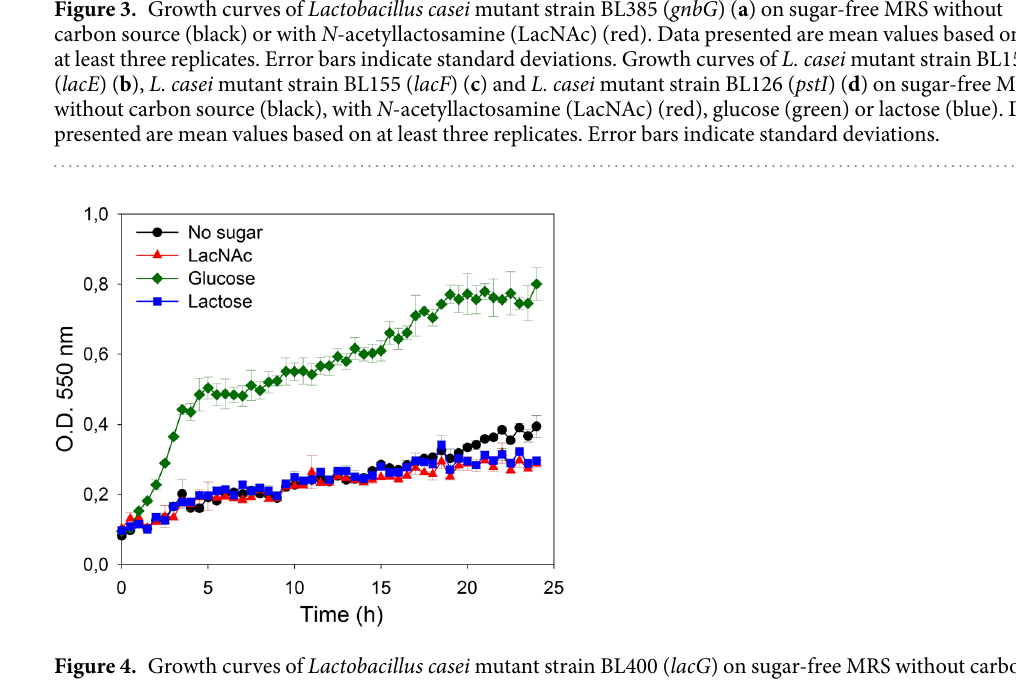
Figure 4. Growth curves of Lactobacillus casei mutant strain BL400 ( lacG ) on sugar-free MRS without carbon source (black), with N -acetyllactosamine (LacNAc) (red), glucose (green) or lactose (blue). Data presented are mean values based on at least three replicates. Error bars indicate standard